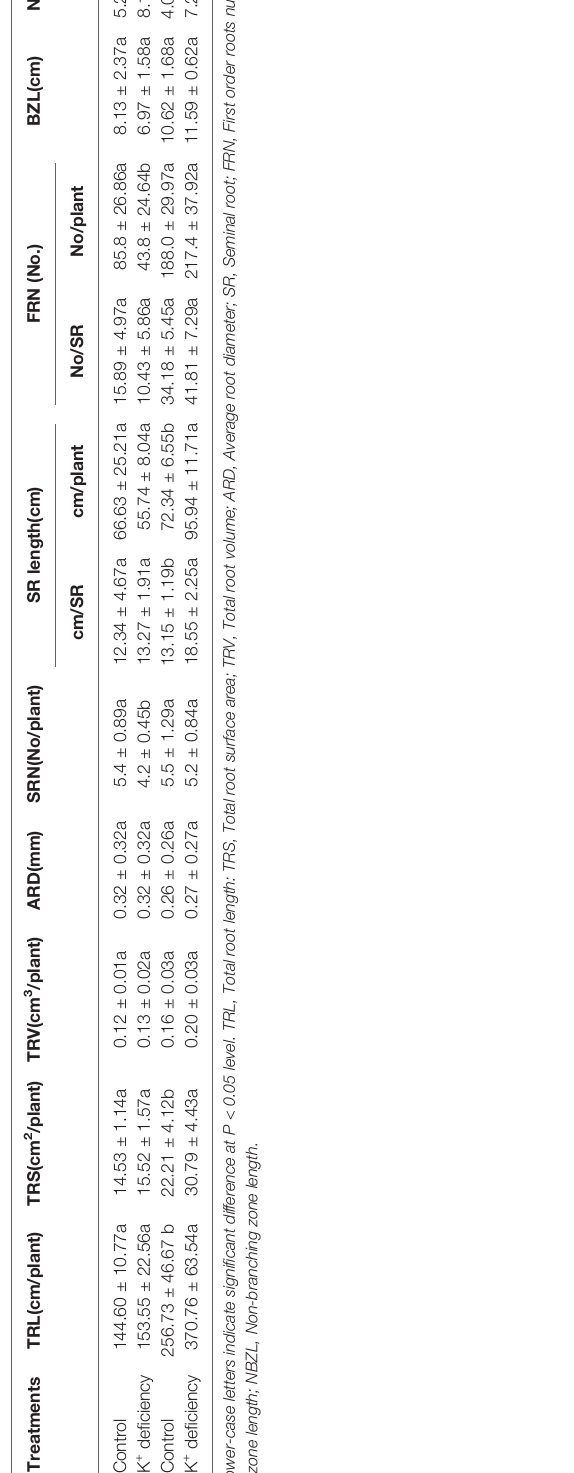
*Different lower-case letters indicate signi fi cant difference at P < 0.05